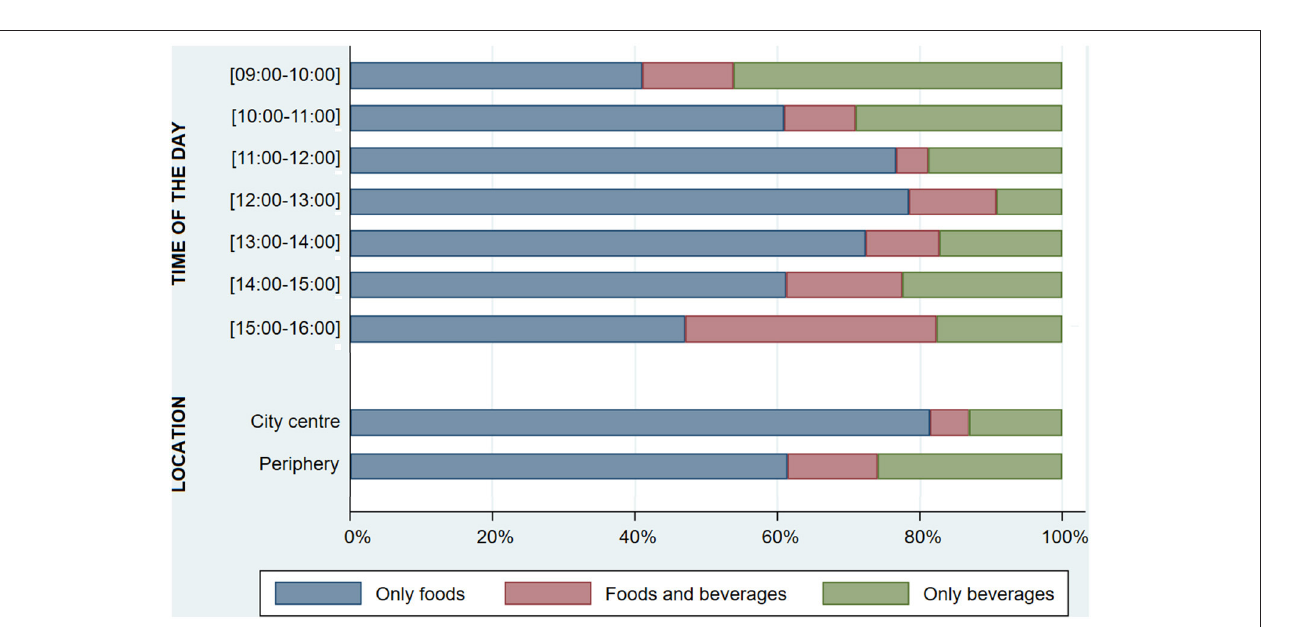
convenience foods (31). Besides convenience, street food